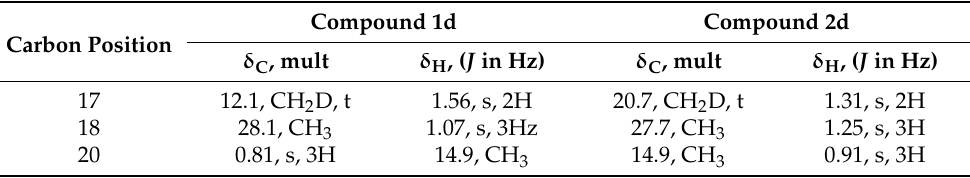
Figure 2. Potential energy diagram of Reb A and degradation compounds 1 – 3 . Compound 1 , compared to Reb A, was more thermodynamically favored with an energy 12.22 kcal/mol lower, indicating this reaction would be expected to continue over time. To confirm the proposed pathway of compound 1 formation (Figure 1, Scheme A), an isotopic-labeling study was conducted with Reb A aged in deuterium-labeled water (D 2 O). NMR analysis of the compound 1 formed during storage in D 2 O revealed a loss of 1H on the C17 methyl located at 1.56 ppm (CH 2 -d) in the proton spectrum (Table 1), along with the presence of a new triplet signal resonating at 12.4 ppm (Figure 3) in the 13 C spectrum, consistent with the proposed mechanism (Figure 1, Scheme A). Therefore, the generation of compound 1 in D 2 O incorporated a single deuterium atom on the C17 methyl group to form compound 1d (Figure 2). Furthermore, an LC–MS analysis of compound 1d generated in D 2 O similarly revealed the addition of one deuterium atom in the elemental Table 1. 1 H and 13 C NMR chemical shifts in deuterated rebaudioside A degradation compounds 1 and 2